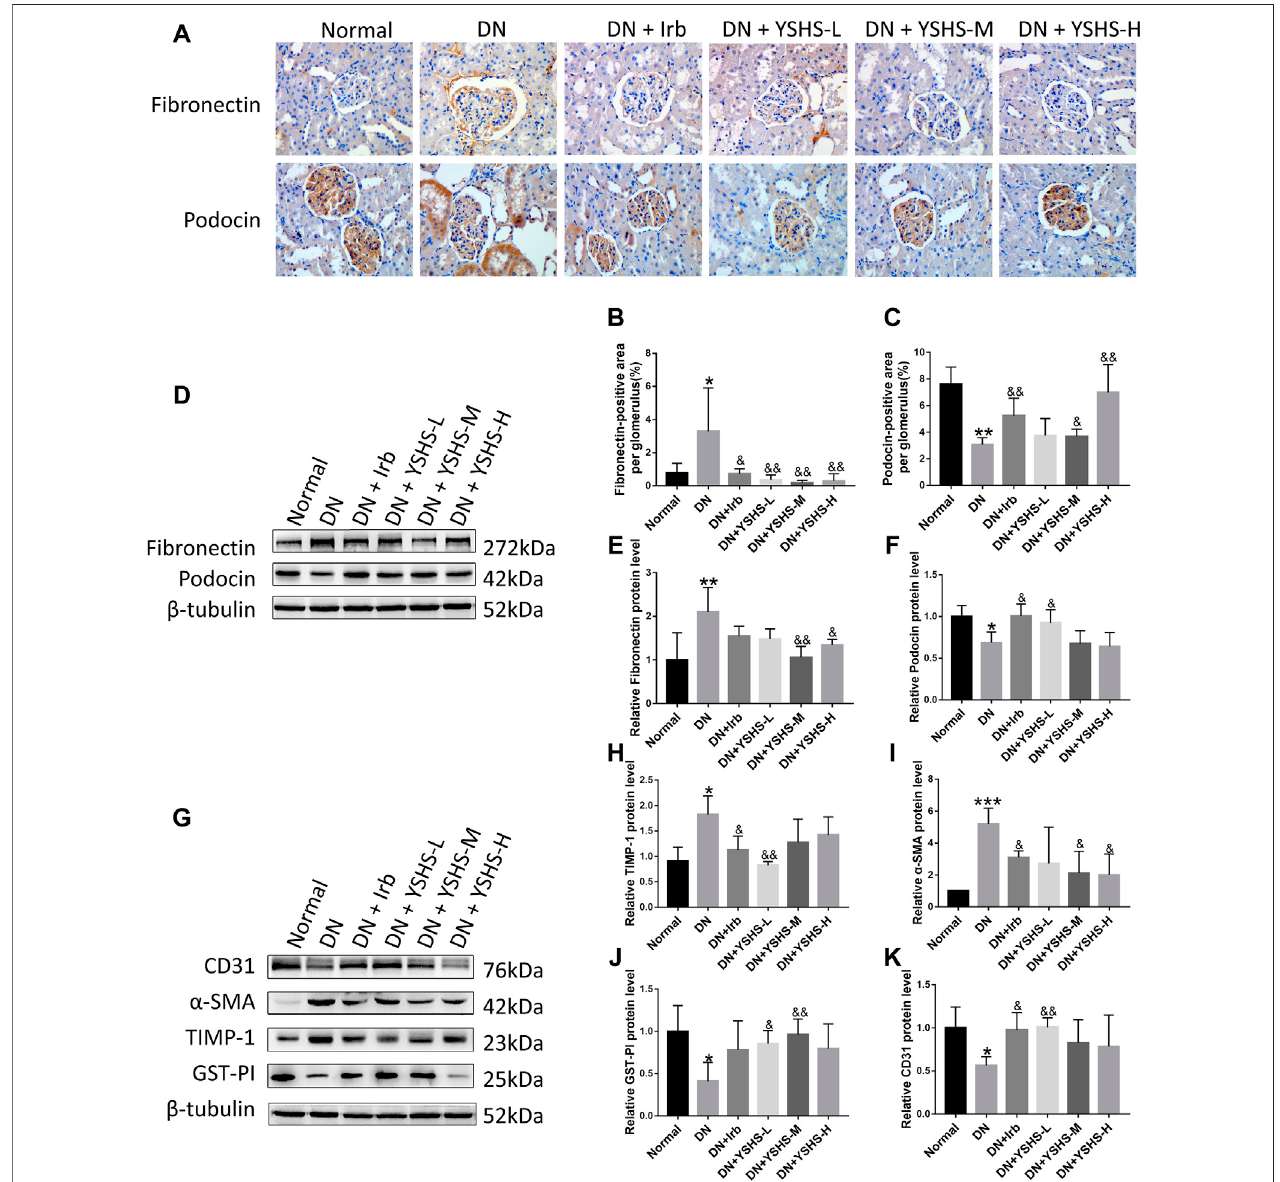
FIGURE 4 | Effects of YSHS on renal fi brosis in DN rats. Podocin and fi bronectin expression was detected by immunohistochemical staining (A) . IHC was quantitatedfor fi bronectin (B) andpodocin (C) usingtheIPPsoftware.Podocinand fi bronectinexpressionwasdeterminedbyWB (D) .Relativeexpressionof fi bronectin (E) and podocin (F) was calculated using ImageJ software. Protein expression of CD31, α -SMA, TIMP-1, and GST-PI in the DN rat was determined by WB (G) . Relative expression of TIMP-1 (H) , α -SMA (I) , GST-PI (J) , and CD31 (K) was analyzed by ImageJ software. Values are presented as means ± SEM. * p < 0.05, ** p < 0.01, *** p < 0.001, vs. Normal; & p < 0.05, && p < 0.01, vs.